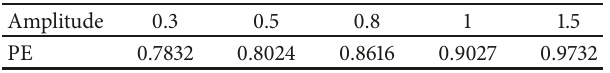
Table 2: The permutation entropy values corresponding to different noise amplitude.